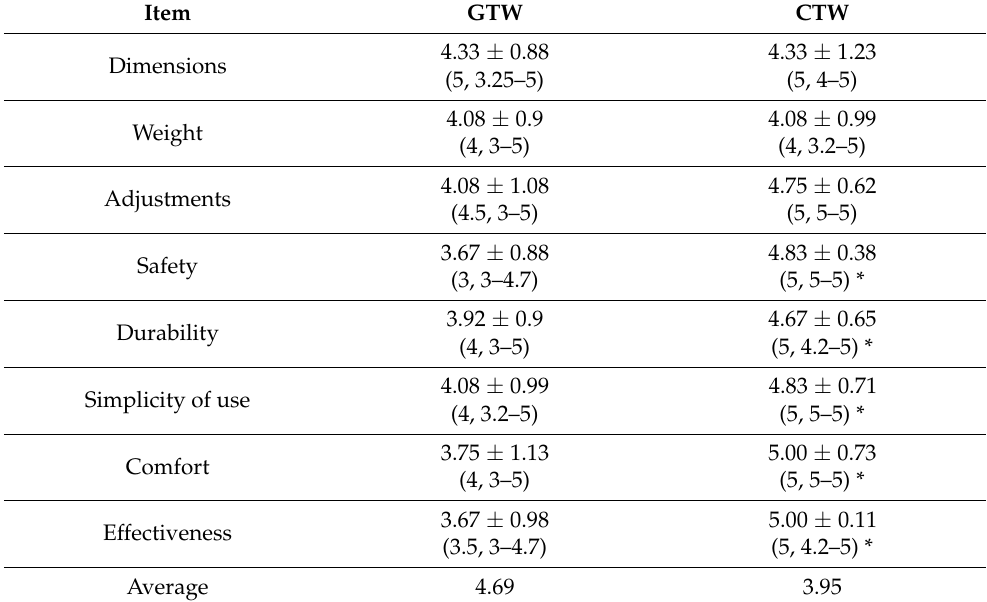
Table 9. Satisfaction.